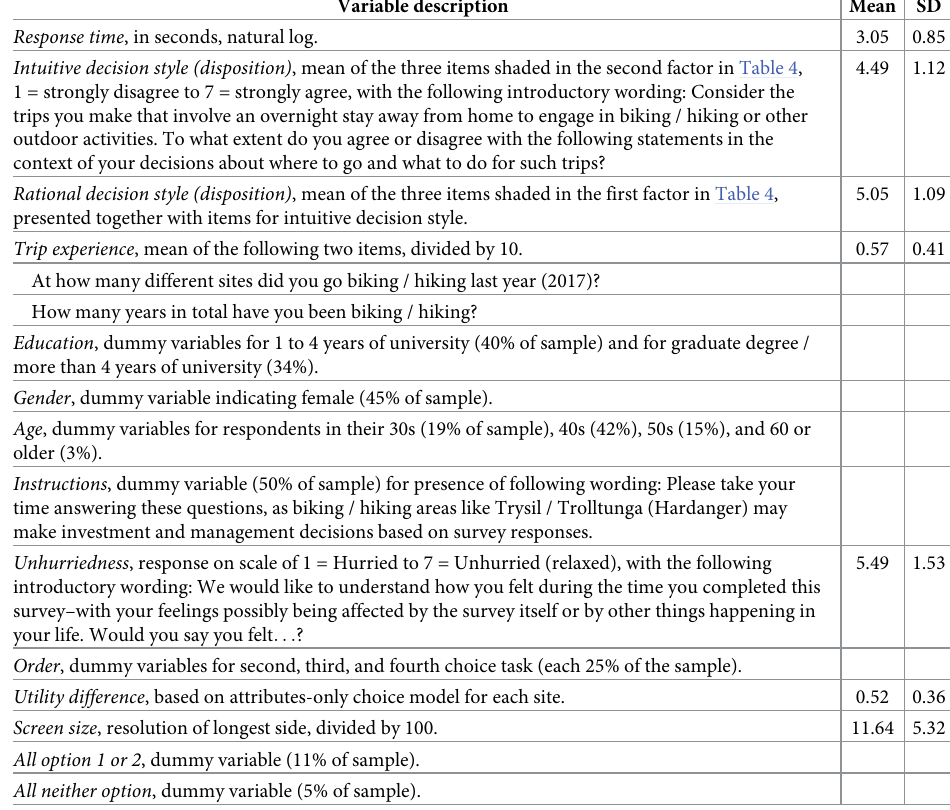
Table 3. Variables and descriptive statistics. Variable description Mean SD Response time , in seconds, natural log.